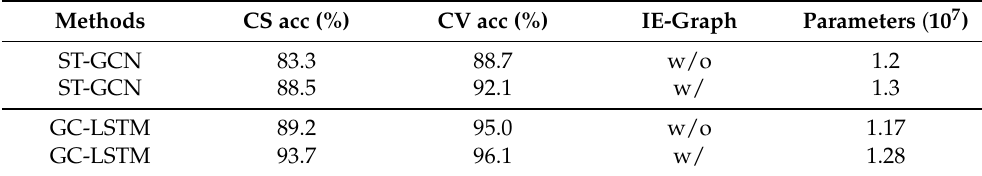
Table 5. Comparison in terms of interaction recognition accuracy of the models w/ and w/o IE-Graph on the NTU60